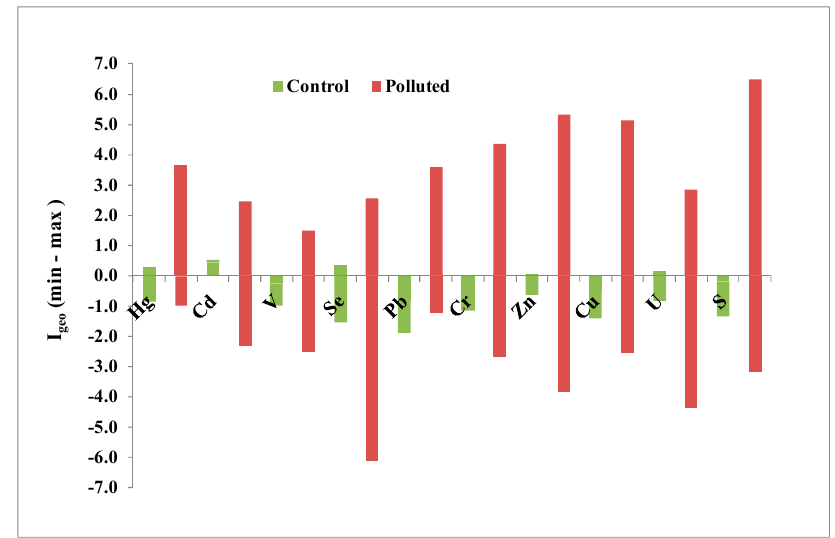
Figure 6. The range values of geo-accumulation indices (I geo ) of analysed elements in control and polluted (Labin) soil samples.